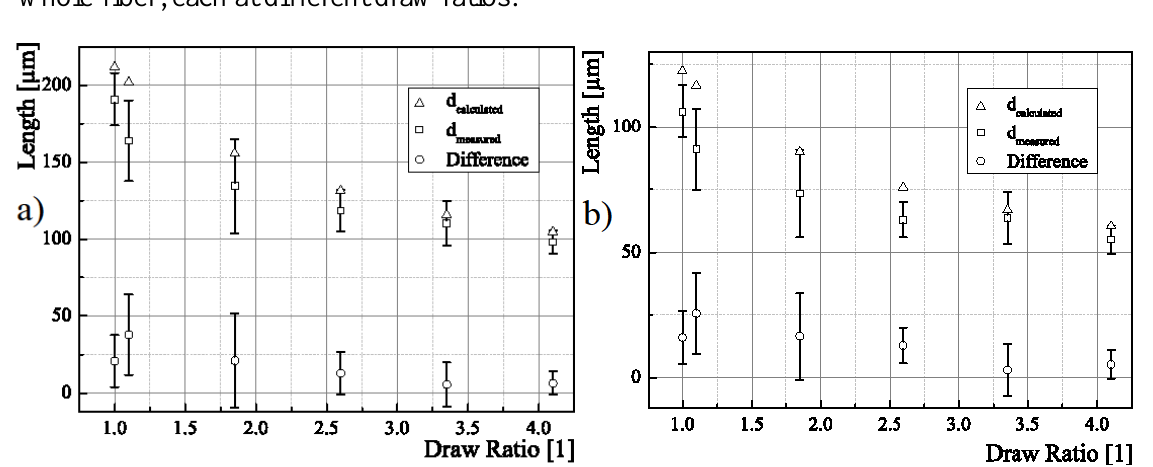
Figure 12. Measured diameters from bright field imaging for ( a ) core only and ( b ) the whole fiber, each at different draw